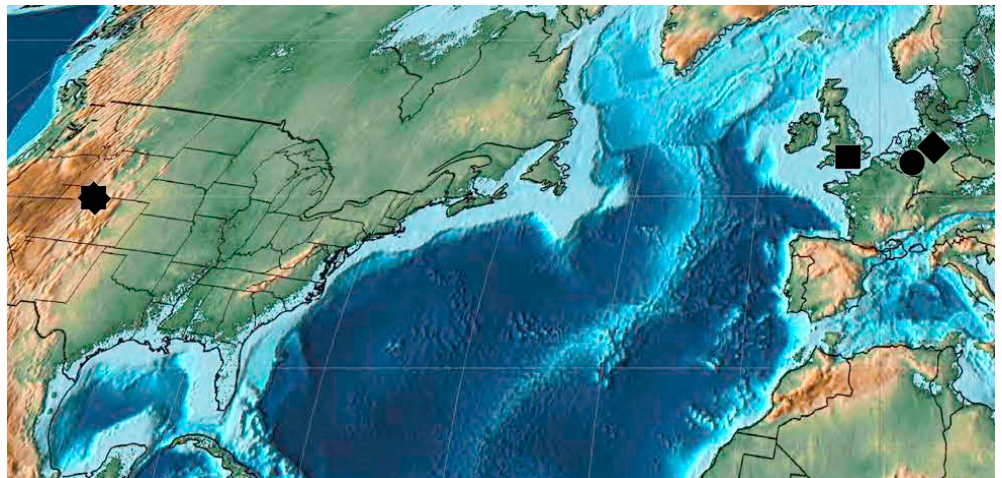
Figure 9. Lutetian Curculionoidea deposits: octagon—Roan Mountain and Green River; square—Corfe